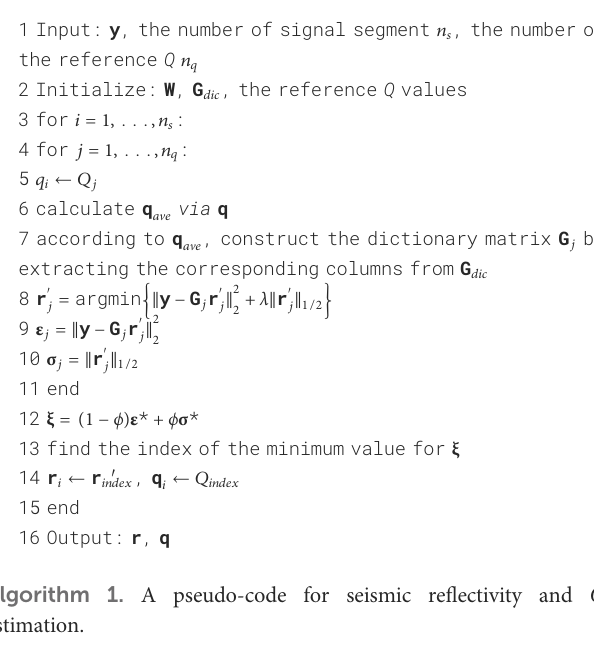
Algorithm 1. The estimated re fl ectivity series are shown in Figures 3D – F.